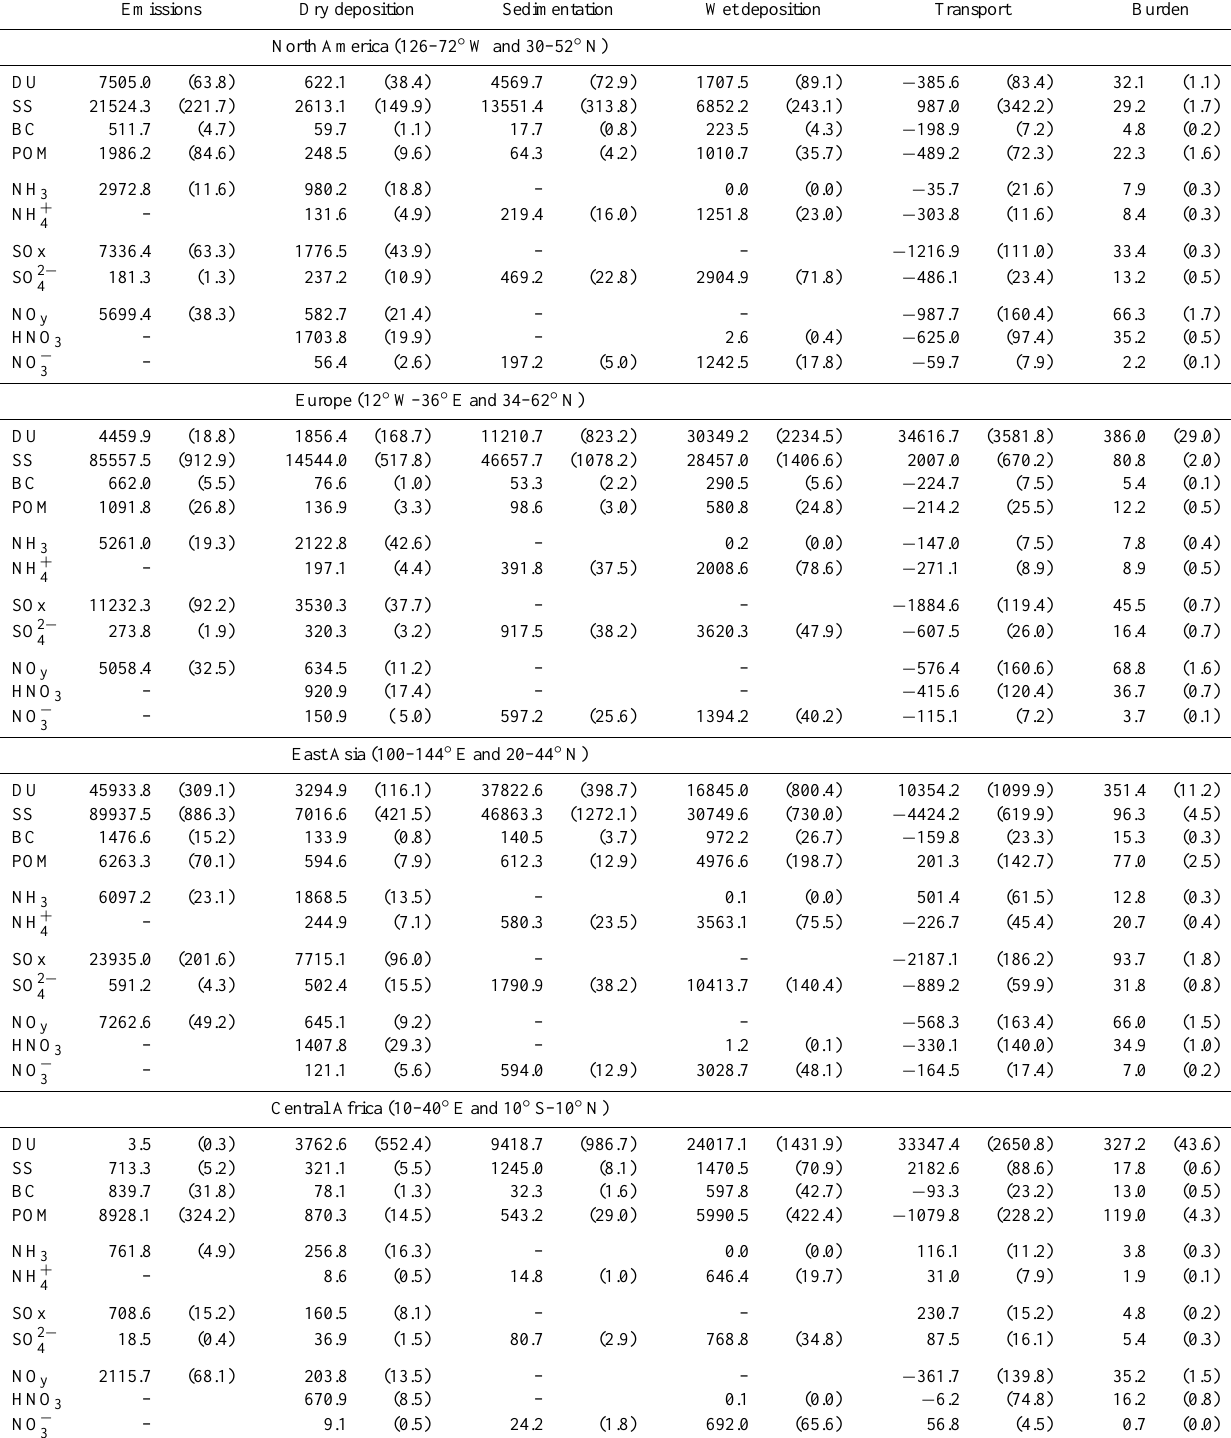
Table 5. Regional aerosol budgets. All units in Gg(species)yr − 1 , except nitrogen and sulfur compounds (expressed as GgNyr − 1 and GgSyr − 1 , respectively) and the species are as in Table 4. The transport is positive (negative) associated with a net import (export) to (from) the region. The yearly standard deviation is listed in